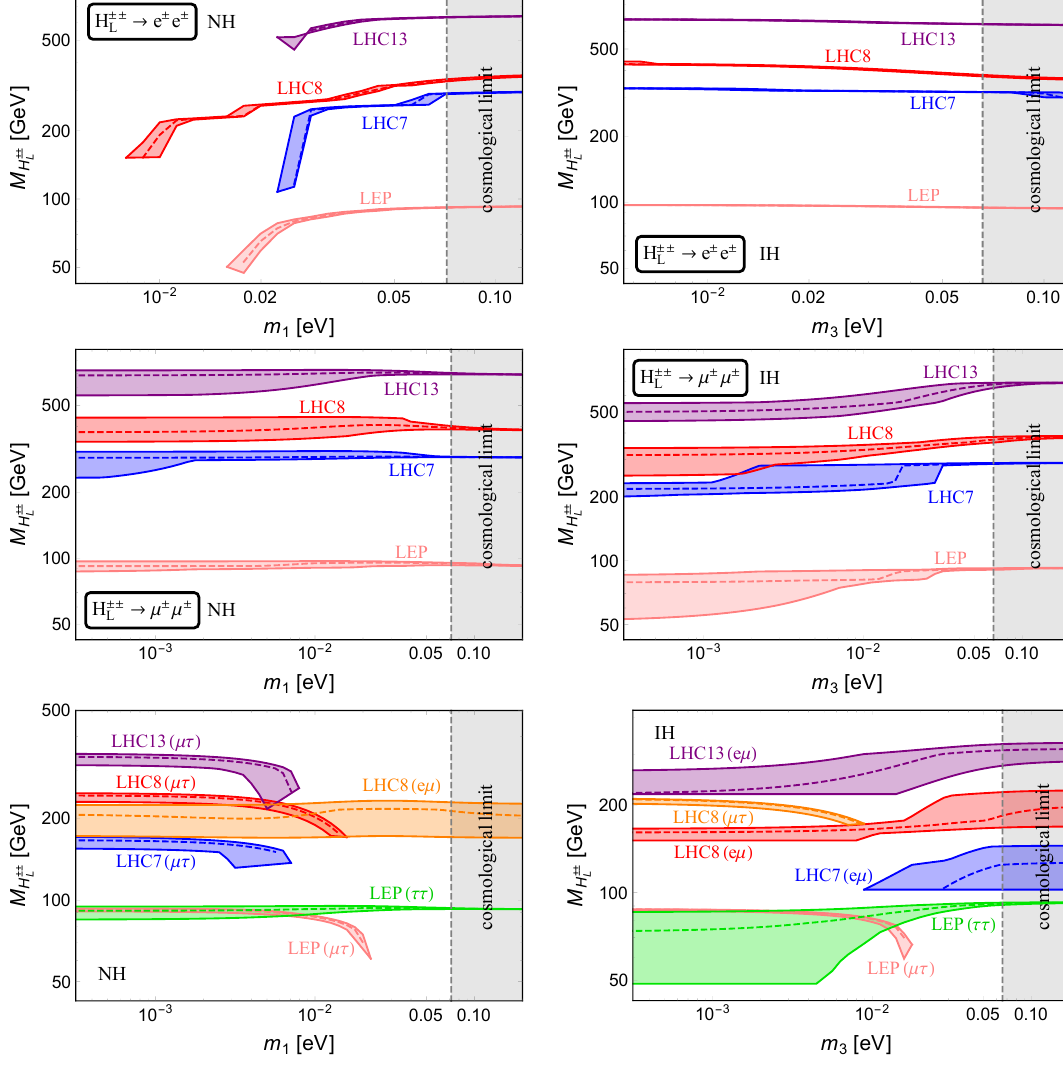
Figure 5 . Lower limits on M in the type-II seesaw, as functions of the lightest neutrino mass H (cid:6)(cid:6) L for NH (left) and IH (right), for di(cid:11)erent (cid:13)avor combinations H (cid:6)(cid:6) ! ‘ (cid:6) ‘ (cid:6) , derived from the data (cid:11) L (cid:12) in (cid:12)gure 4, in the small v L limit [cf. eq. (2.23)]. The dashed curves corresponds to the central values of neutrino data in table 1, and the colorful shaded bands are due to the 3 (cid:27) uncertainties. The gray shaded region is excluded by the cosmological constraint on the sum of light neutrino masses P m i < 0 : 23 eV i